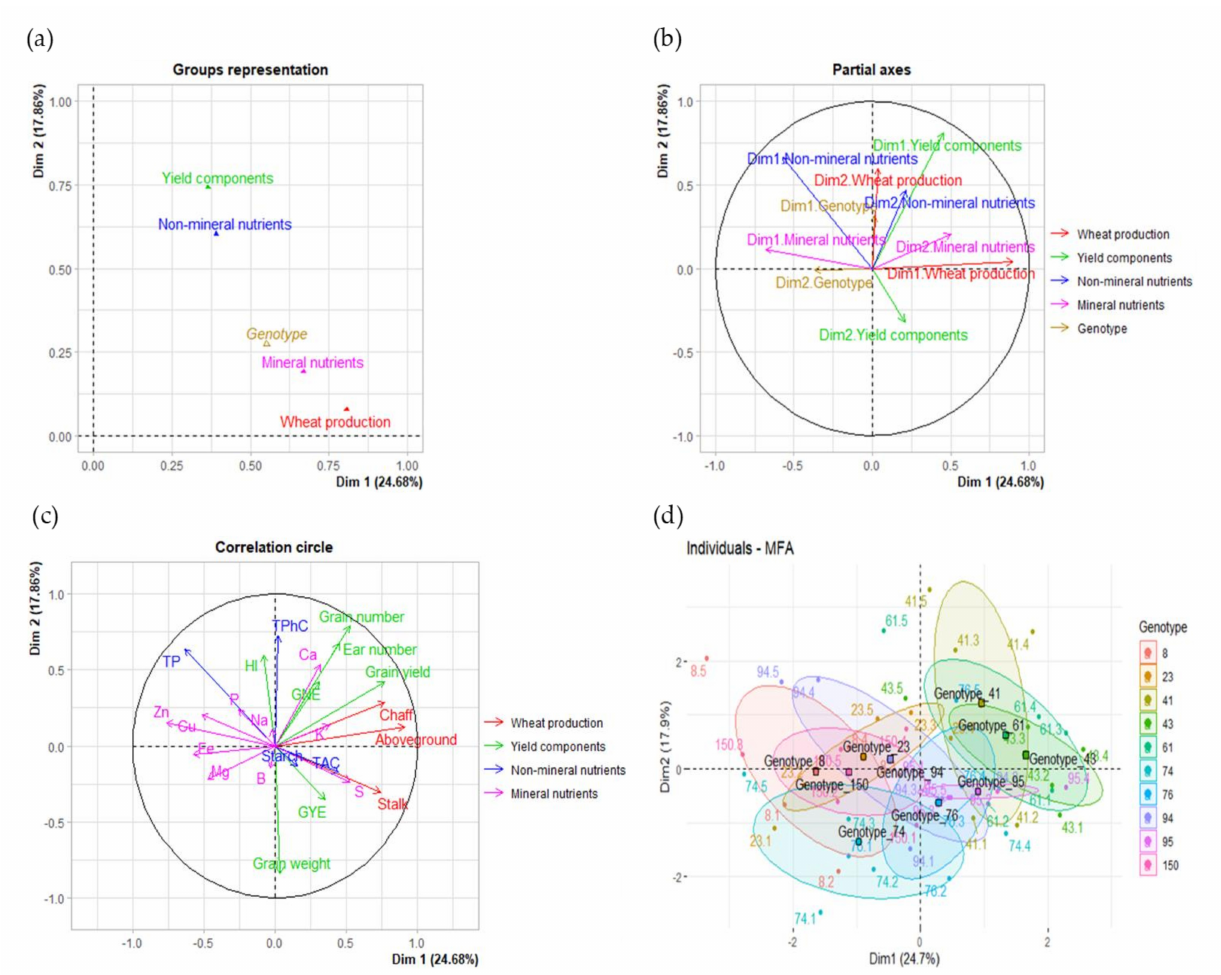
Figure 2. Multiple factorial analysis for the wheat production, grain yield, non-mineral and mineral quality components of 10 wheat genotypes grown under elevated CO 2 and high temperature. Dim. : Dimension; GNE : grain number ear − 1 ; GYE : grain yield ear − 1 ; HI : harvest index; TAC : total antioxidant capacity; TP : total protein; TPhC : total phenolic compounds. Genotype is the group based on a categorical variable specifying the genotypic identity of each sample. The vegetative biomass, grain yield and nutritional quality traits were split up into four groups: Wheat production (aboveground, stalk, and chaff biomasses), Yield components (grain yield, grain number, ear number, grain weight, grain yield ear − 1 , grain number ear − 1 , and harvest index), Non-mineral nutrients (starch, total protein, total phenolic compound concentrations, and total antioxidant capacity) and Mineral nutrients (B, Ca, Cu, Fe, K, Mg, Na, P, S, and Zn mineral concentrations). ( a ) The group representation plot illustrates the correlation between the variable groups and the supplementary group with axes; ( b ) The partial axes plot shows the relationship between the main axes of the MFA and the first two dimensions of each group. ( c ) The correlation circle plot represents the correlation of traits with the MFA axes. ( d ) The individual plot exhibits the position of individuals in the MFA by genotype variation. Triangles indicate the relative position of each group with the axes. Dots represent individuals. Squares represent group mean points for categorical variables. Ellipses around each genotype ( d ) were